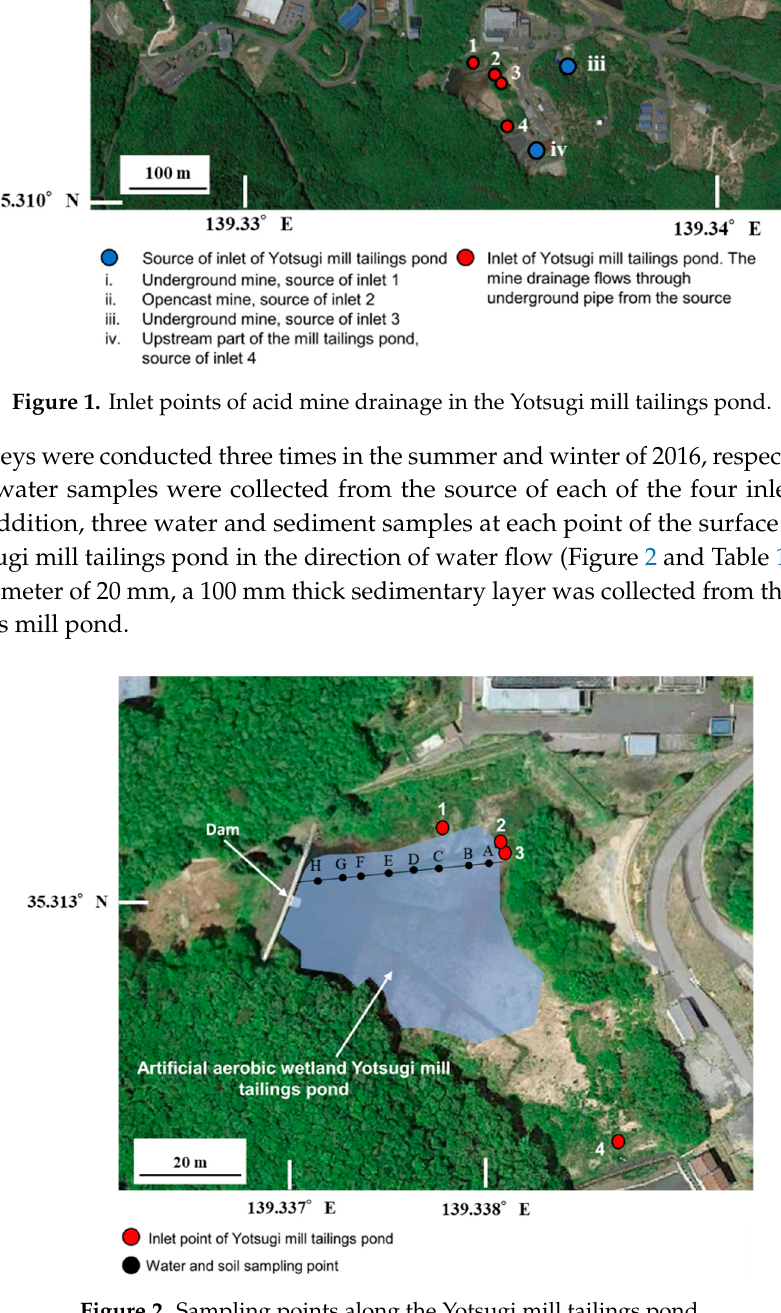
Figure 2. Sampling points along the Yotsugi mill tailings pond. Table 1. The distance of the sampling points from A in the Yotsugi mill tailings pond (m). Point A B C D E F G H Distance